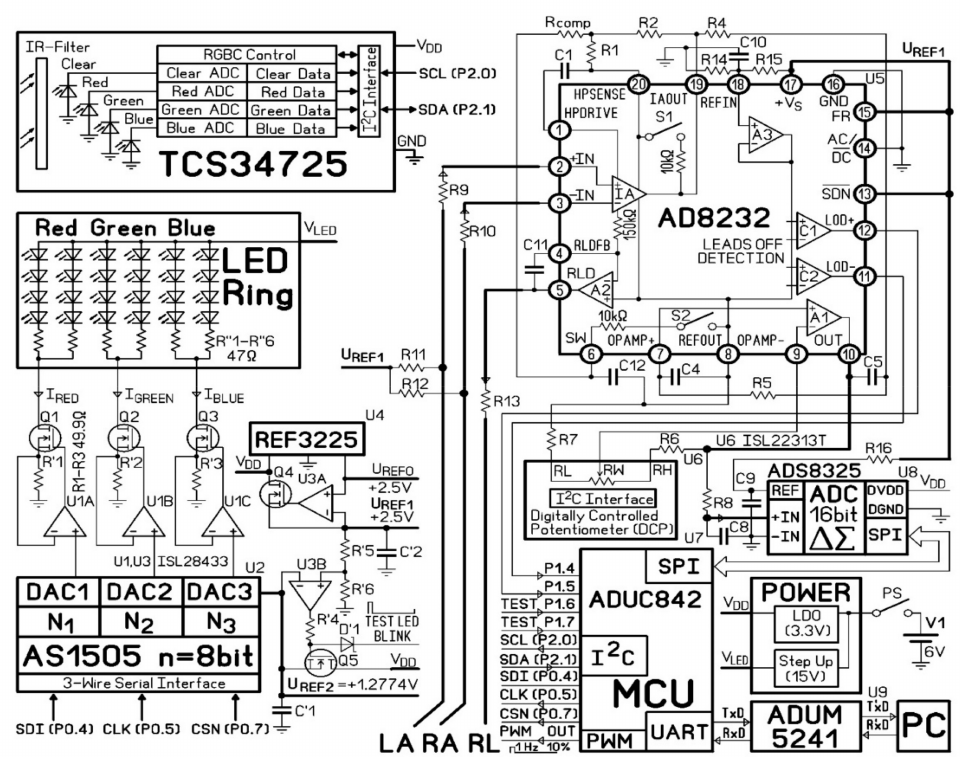
Figure 2. The circuit